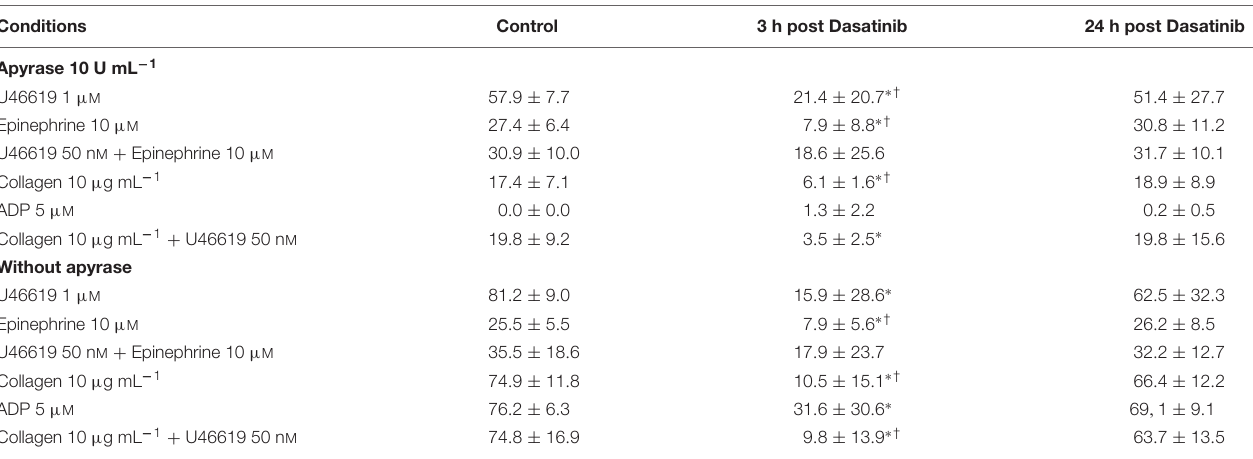
TABLE 3 | Effect of dasatinib on platelet aggregation (% aggregation at 5